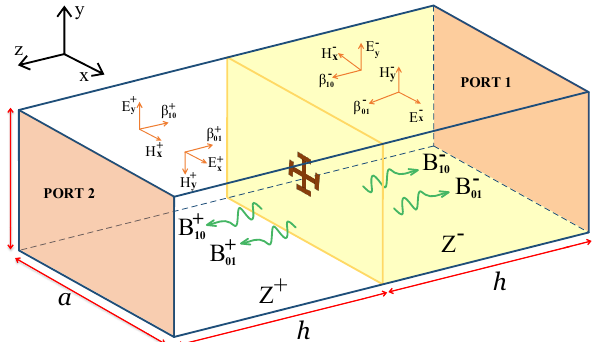
Figure 1: Waveguide simulation structure. In general case, the scatterer is placed in the center of the waveguide at z=0. The region z<0 and z>0 have characteristic impedance 𝑍 F and 𝑍 G ,